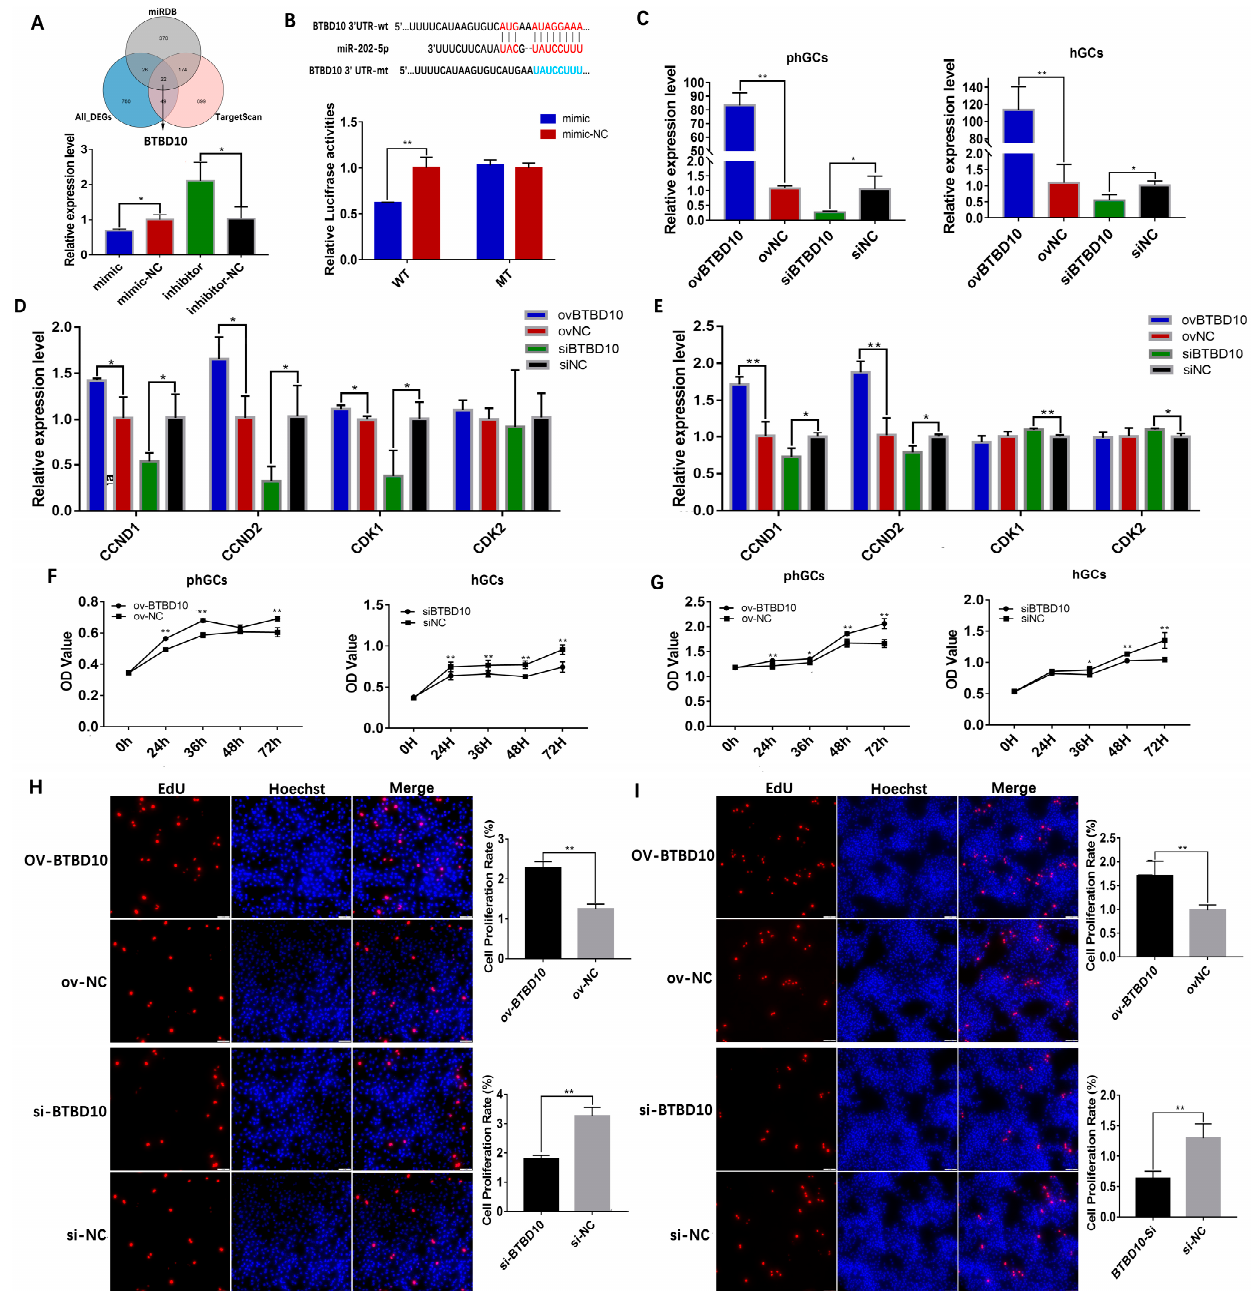
Figure 5. Effect of BTBD10 on the proliferation of phGCs and hGCs. ( A ): the overlapping genes between TargetScan and miRDB databases predict target genes and DEGs (up), and the validation of the influence of miR-202-5p on the expression of predicted genes by qRT-PCR (n = 3); ( B ): schematic illustrating the design of luciferase reporters with miR-202-5p binding sites in wild type BTBD10 3 ′ UTR (WT) or mutant type BTBD10 3 ′ UTR (MT) (up), and di ff erences in relative luciferase of BTBD10 WT and MT vectors after transfection with mimic activities (down) (n = 3); ( C ): identi fi cation of overexpression and interference e ff ect of ovBTBD10 and siBTBD10 in phGCs and hGCs (n = 3); the e ff ect of overexpression/interference of BTBD10 on the expression of proliferation-related genes in phGCs ( D ) and hGCs ( E ) detected by qRT-PCR (n = 3); the e ff ect of overexpression/interference of BTBD10 on the cell activity of phGCs ( F ) and hGCs ( G ) detected by CCK8 (n = 6); the e ff ect of overexpression/interference of BTBD10 on the proliferation rate of phGCs ( H ) and hGCs ( I ) detected by EdU staining (n = 3). Data are means ± SD of technical replicates. * p < 0.05, ** p < 0.01.